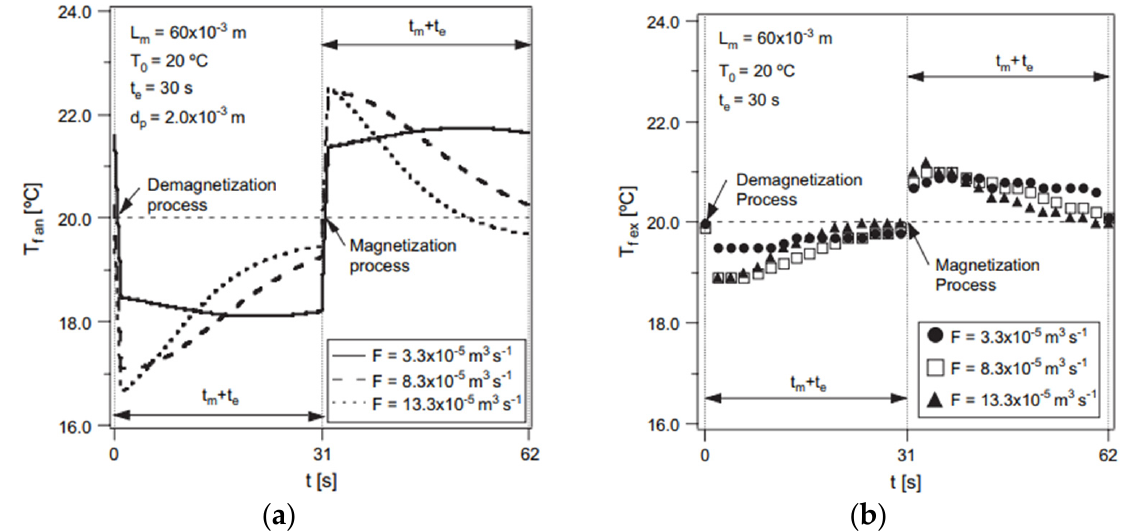
Figure 4. Comparison of the analytical and experimental results of air temperatures for a given volumetric flow rate F: ( a ) analytical; ( b ) experimental results [37].